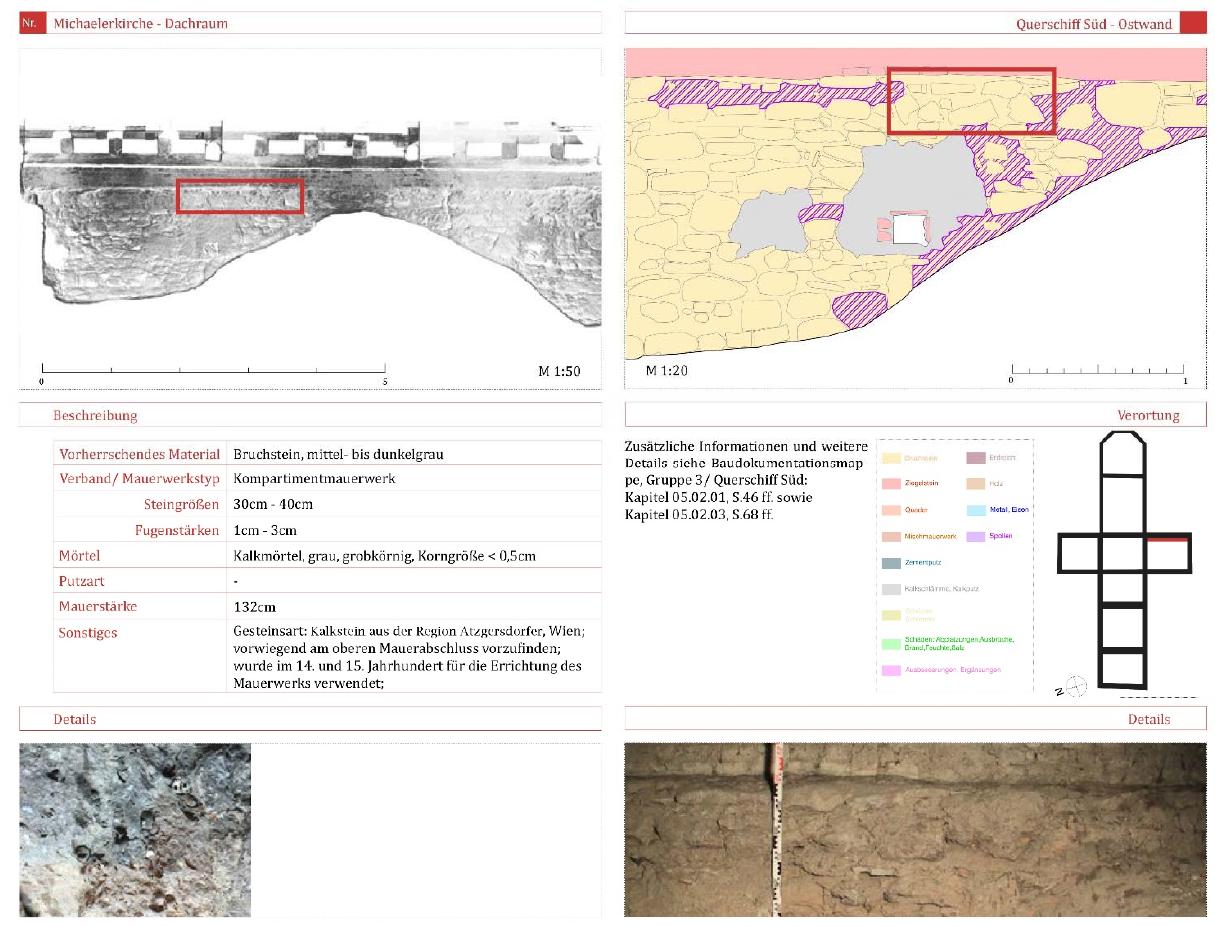
Figure 12. Masonry catalogue, St. Michael, Vienna ©